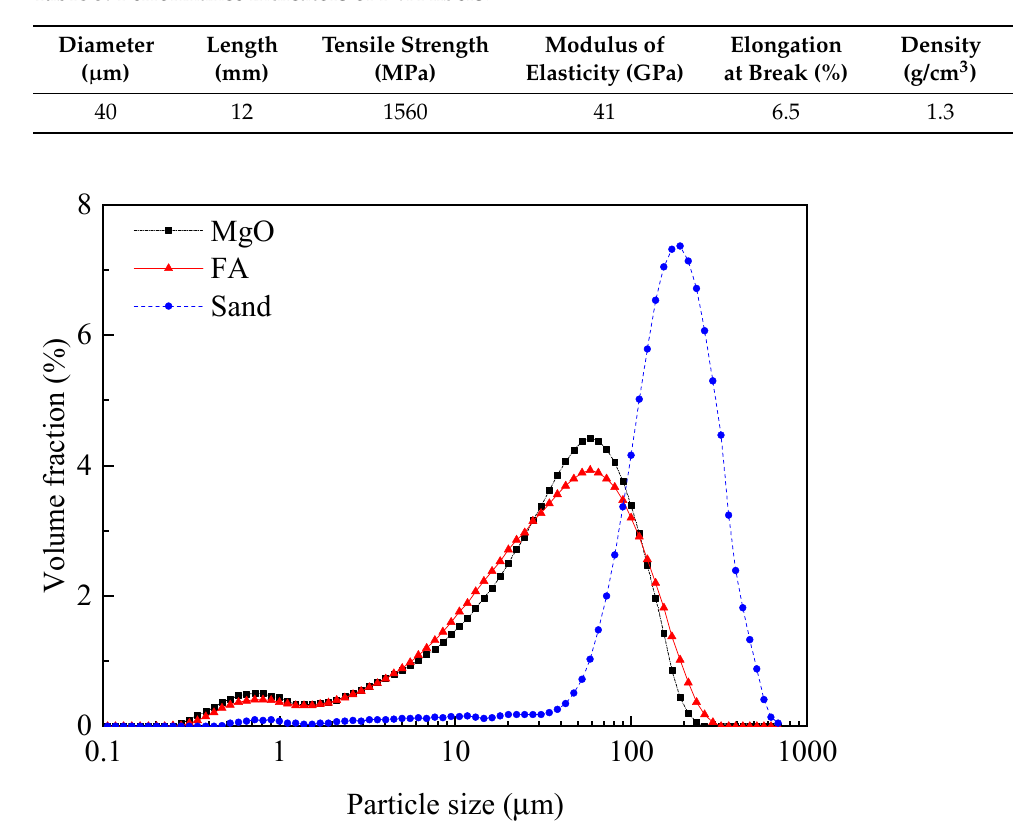
Table 5. Performance indicators of PVA fibers.